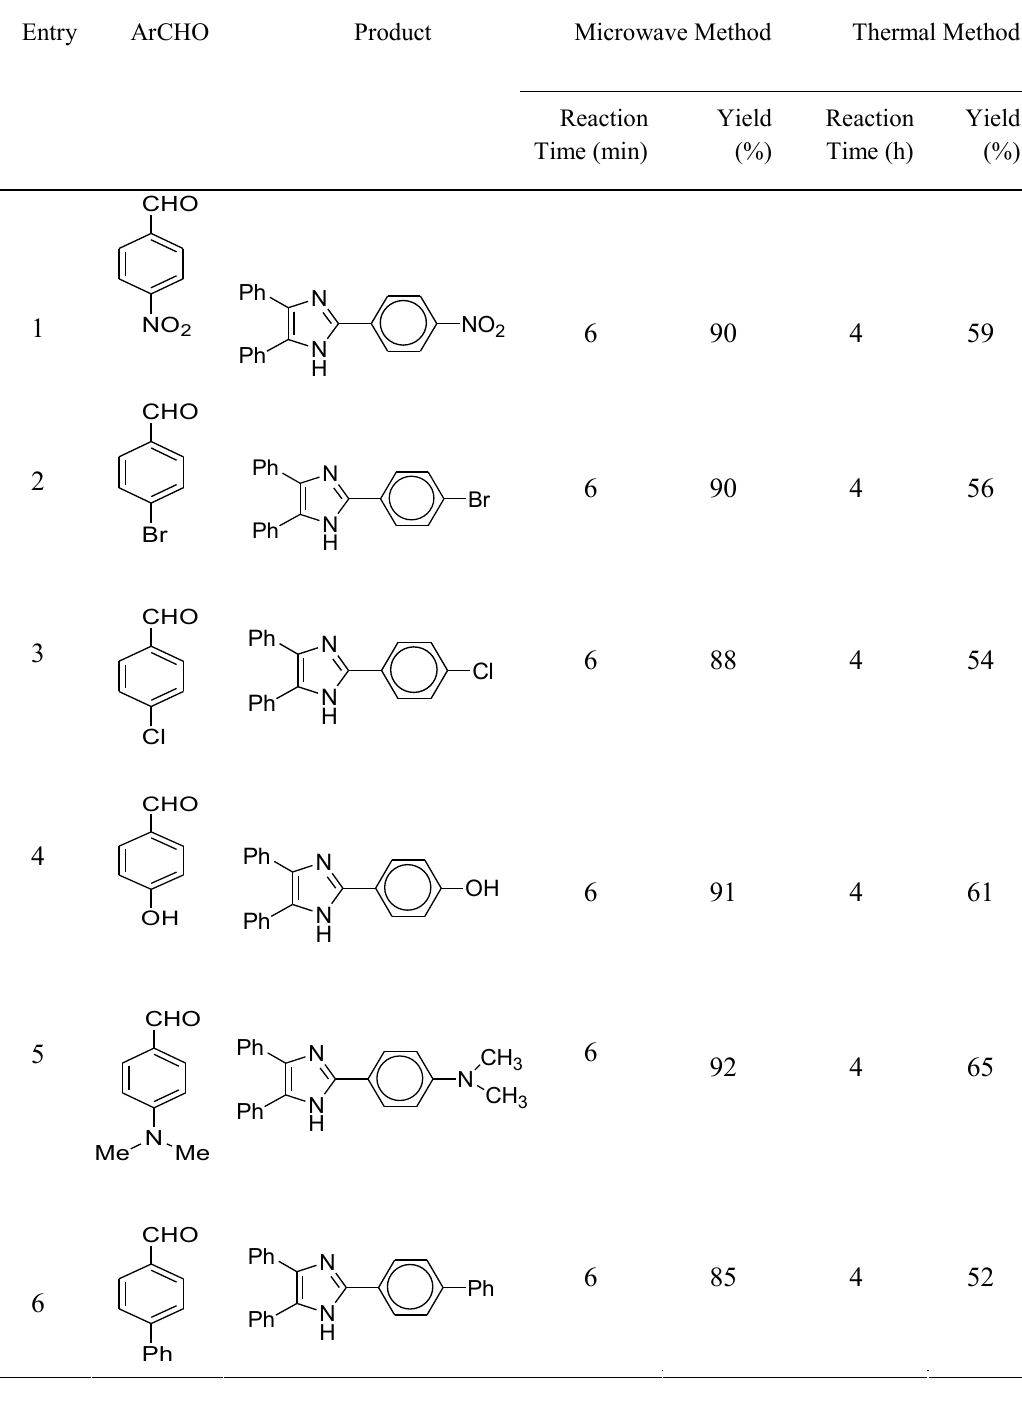
Table 2. The synthesis of trisubstituted imidazoles using benzyl, Ammonium acetate and substituted Aldehydes under different